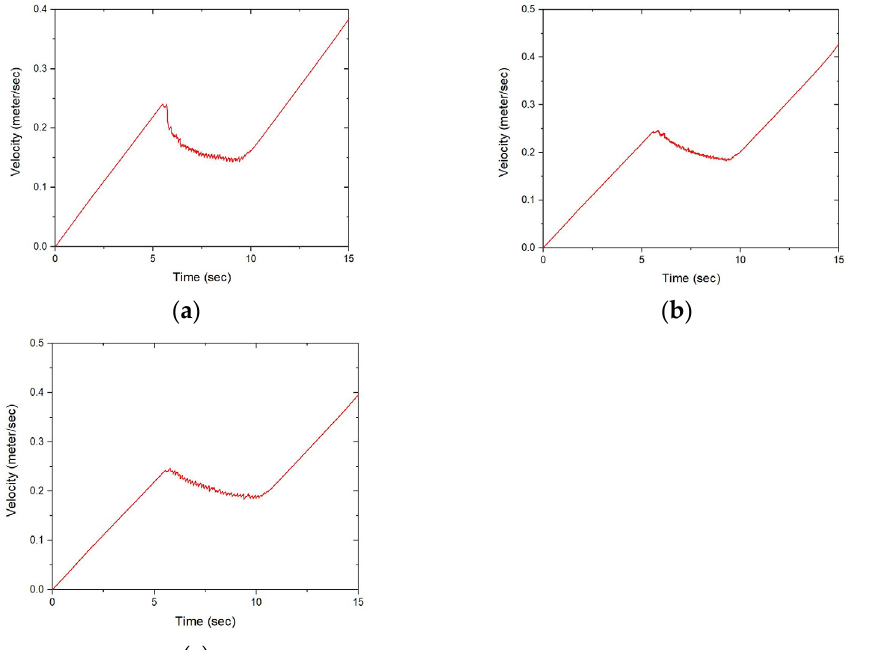
Figure 20 . Robot movement speed with di ff erent turning radii: ( a ) 400 mm robot movement speed;